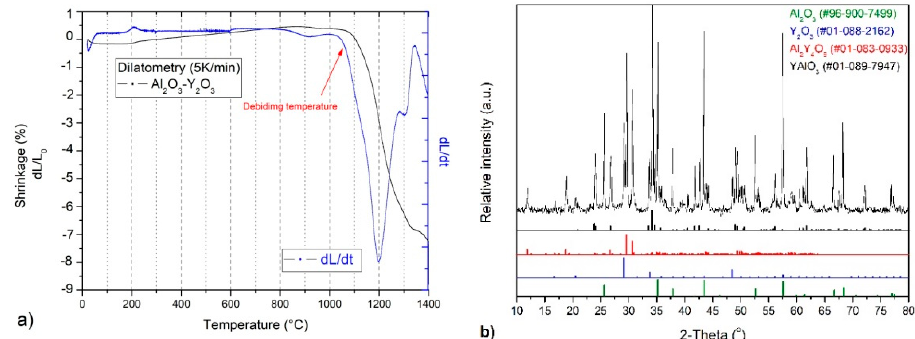
Figure 5. ( a ) Dilatometry curve (room temperature → 1400 °C) referring to sintering of optimized Al 2 O 3 –Y 3 O 2 ceramic ink; ( b ) XRD pattern of the DIW structure sintered at 1200 °C; ( b ) example of a fully sintered